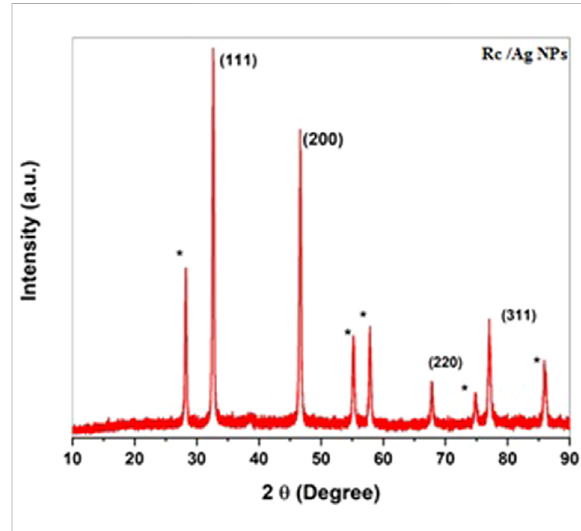
FIGURE 6 XRD patterns of Ag nanoparticles obtained by sumac- mediated green